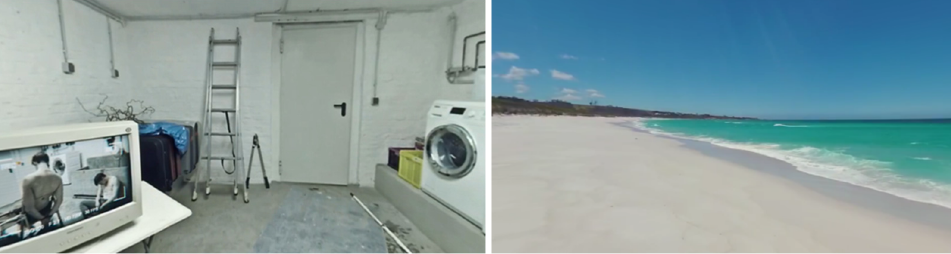
Figure 6. Screenshots for fear and calm video visualization.